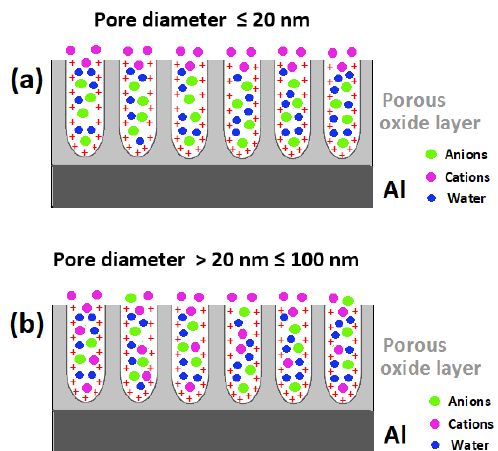
Figure 7. Combined effect(s) of the positive surface charge and the nanometric dimensions of pores of anodic aluminum oxide films on the transport of species into the pores during sealing (The red “+” sign denotes the positive charge on the pore wall surface for simplicity the generated electric field is not presented).